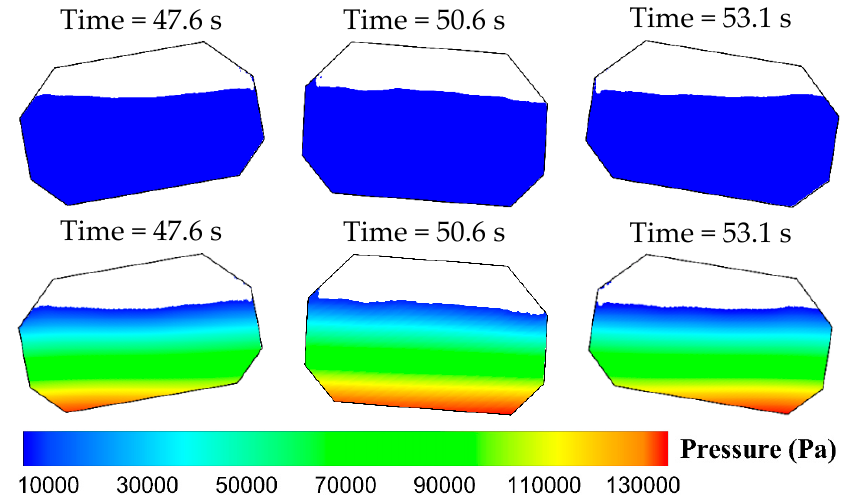
Figure 11. Snapshots of free surfaces ( first line ) and corresponding pressures ( second line ) in the case T = 10.0 s at various